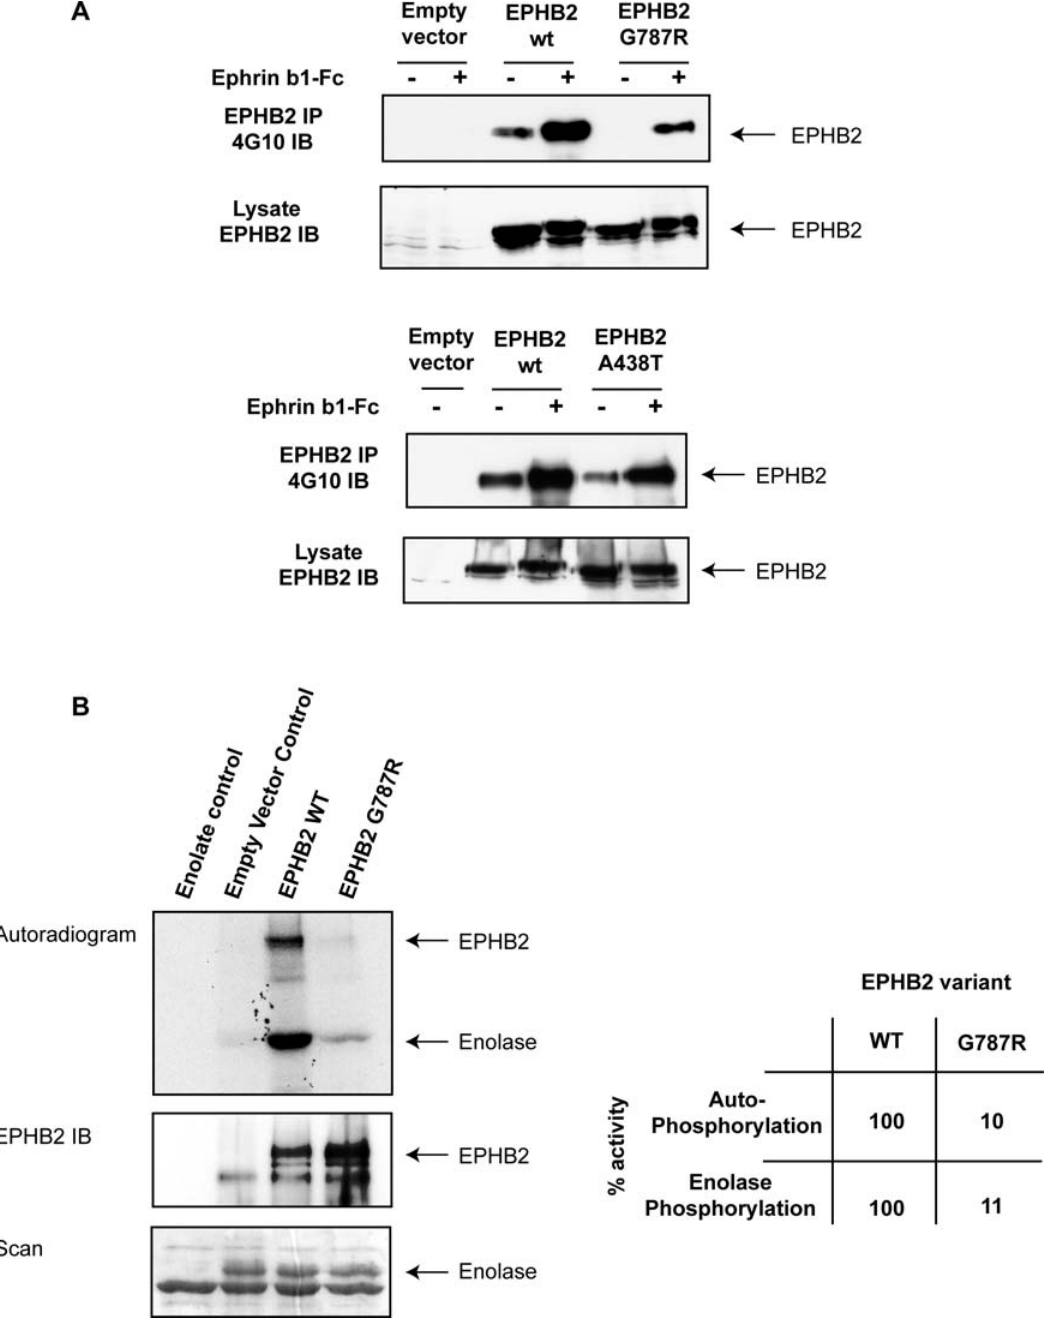
Figure 3. Biochemical characterization of EPHB2 variants. Panel A: Diminished autophosphorylation of EPHB2 G787R variant in response to ephrinB1 stimulation. DU145 cells were transiently transfected with cDNA constructs (empty vector; wild-type, wt; A438T; G787R) and either left unstimulated ( 2 ) or stimulated ( + ) with preclustered ephrinB1-Fc for 30 min. EPHB2 was immunoprecipitated (IP) and immunoblotted (IB) with antiphosphotyrosine (4G10) to evaluate receptor autophosphorylation. The cell lysate was immunoblotted with antiEPHB2 to ascertain that there was equal transfection efficiency. Panel B: Abolished kinase activity of EPHB2 G787R variant. In vitro kinase assays were performed using wild-type EPHB2 or G787R immunoprecipitates and enolase as the exogenous substrate. Prior to imaging or immonoblotting against EPHB2, phosphorylated proteins were separated by gel electrophoresis and stained with coomassie. Autoradiogram showing 32 P c ATP incorporation in EPHB2 and enolase (upper panel), anti-EPHB2 immunoblot (middle panel) and equal loading of enolase is shown (lower panel). The table shows the relative kinase activity of the wild-type EPHB2 receptor (set to 100%) vs. the G787R variant.